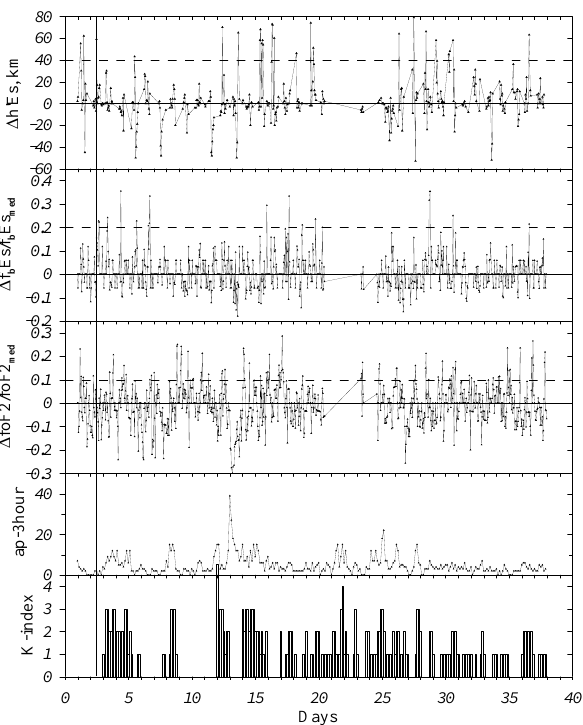
Fig. 1. Observed 1h 0 Es, δ fb Es, and δ fo F2 along with 3-h ap and local K-indices for the whole preparation period (3 March 2009–6 April 2009) of the earthquake at L’Aquila. Dashes – the thresholds corresponding to the precursor selection criteria. Vertical solid line is the precursor date.